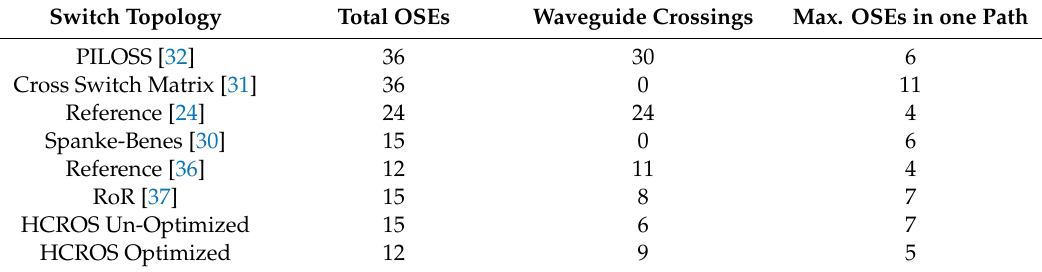
Table 9. Hardware cost comparisons and analysis for N =